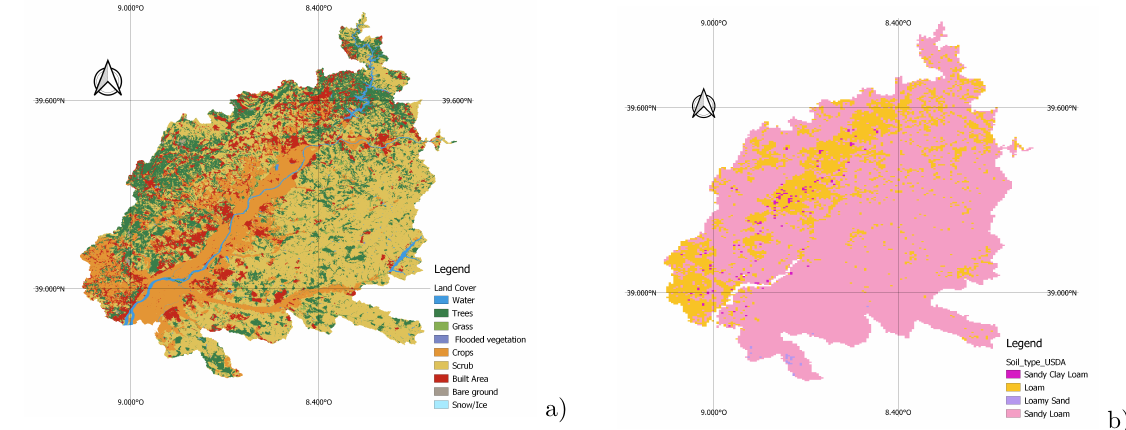
Figure 11. Data collection of vulnerability factors: a) Land Cover and b) Soil